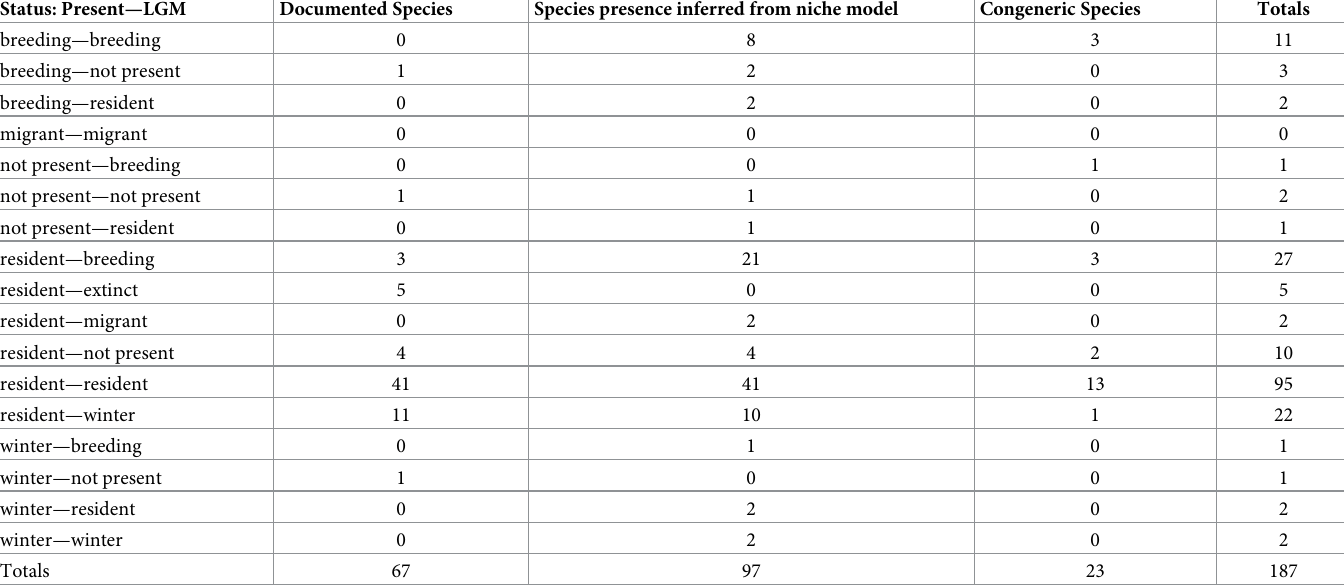
Table 2. Shifts in residency and/or migratory behavior in birds documented or potentially present at La